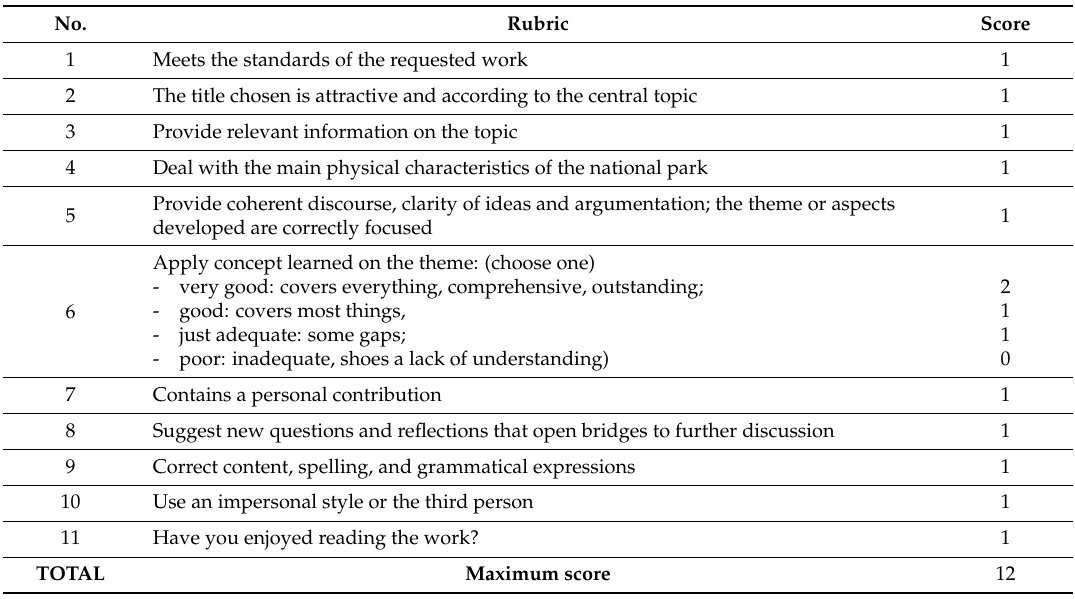
Table 2. Rubrics already established for students and scores for each